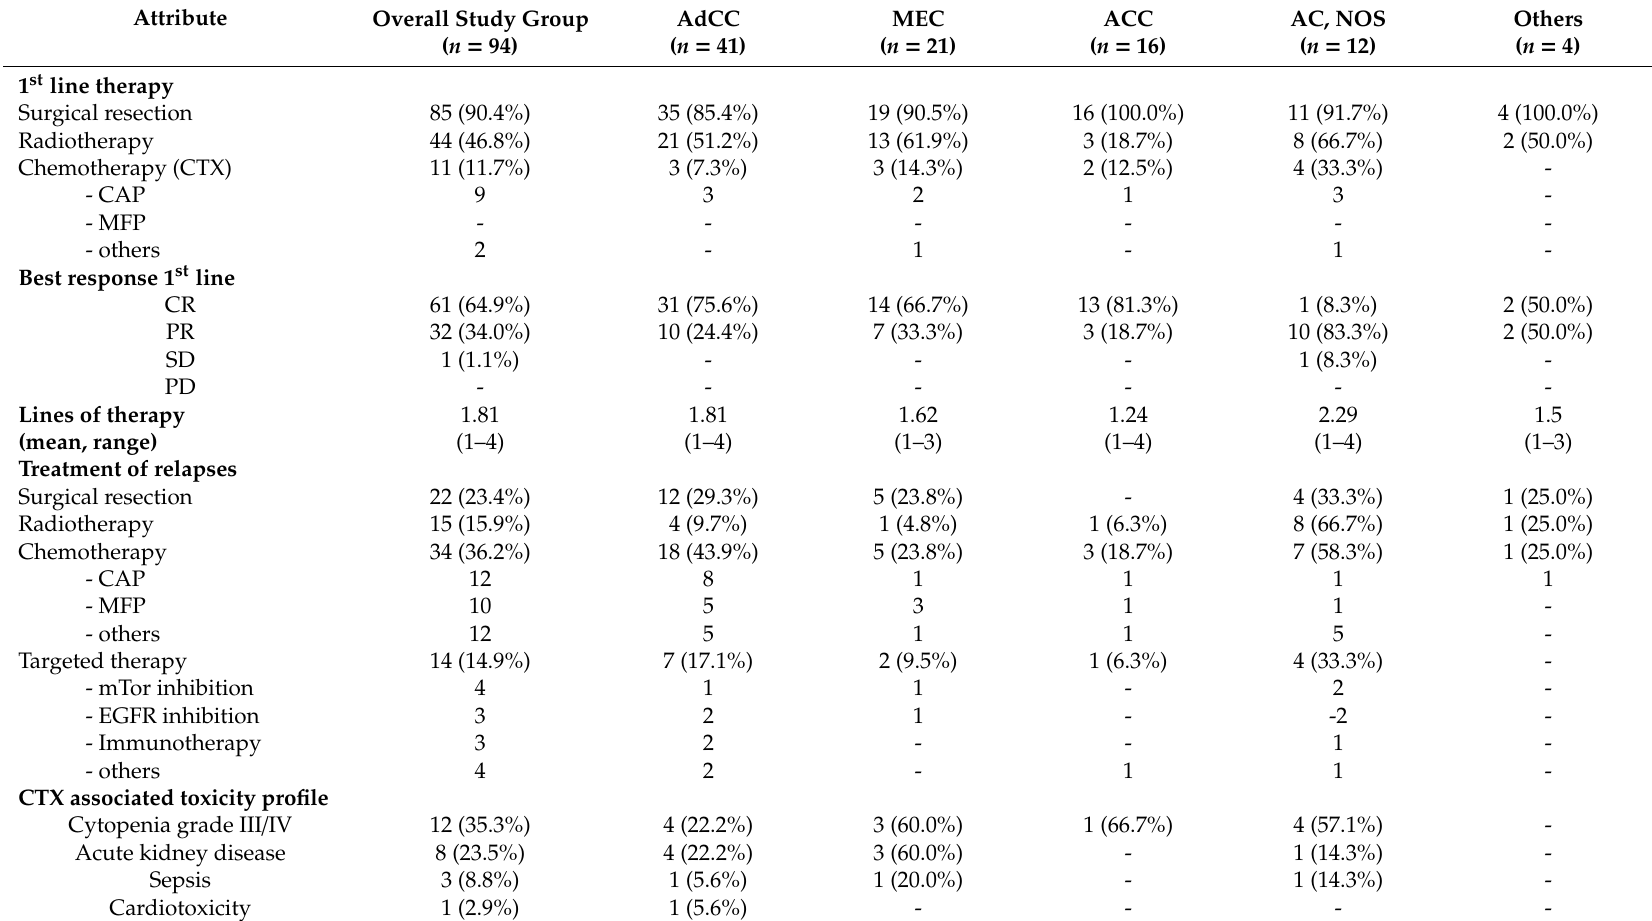
Table 3. Treatment modalities of patients with salivary gland carcinoma included in the